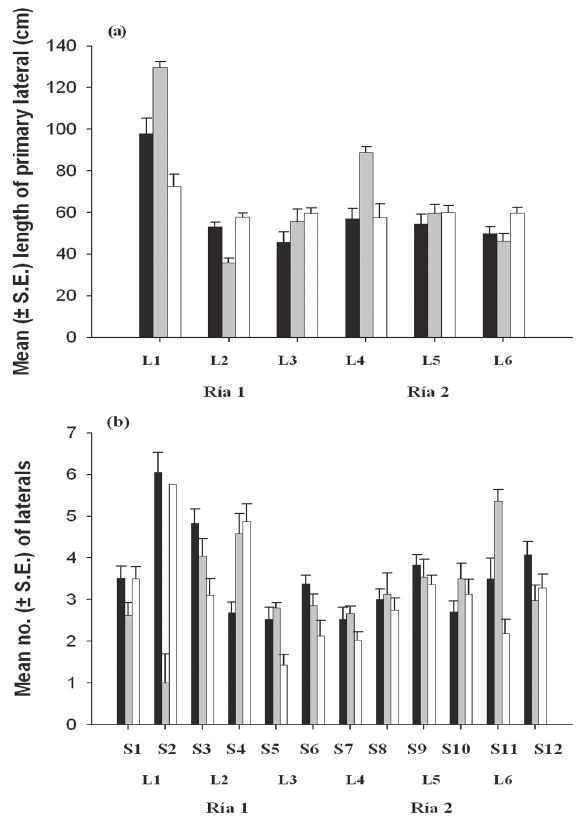
Fig . 4. – temporal v ariation of morphological variables at location and site scales, respectively. Mean (± s.e.) of (a) length of primary lateral (cm) at each of the 3 locations within the 2 rias (n = 72) and (b) number of laterals at each of the 2 sites, at the 3 locations within the 2 rias (n = 36). black, grey and white bars represent March, april and July, respectively. ria 1: ría de vigo; ria 2: ría de